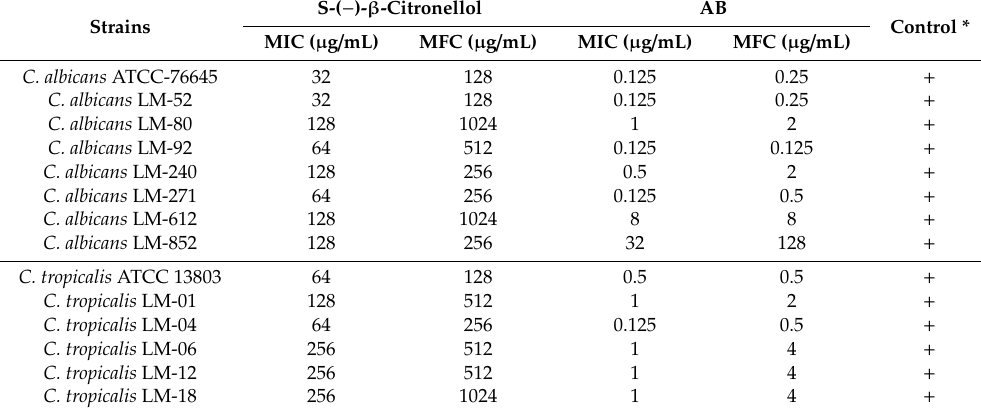
Table 2. MIC and MFC for S-( − )- β -citronellol and AB against strains of C. albicans and C. tropicalis . S-( − )- β -Citronellol AB Strains MFC ( µ g /